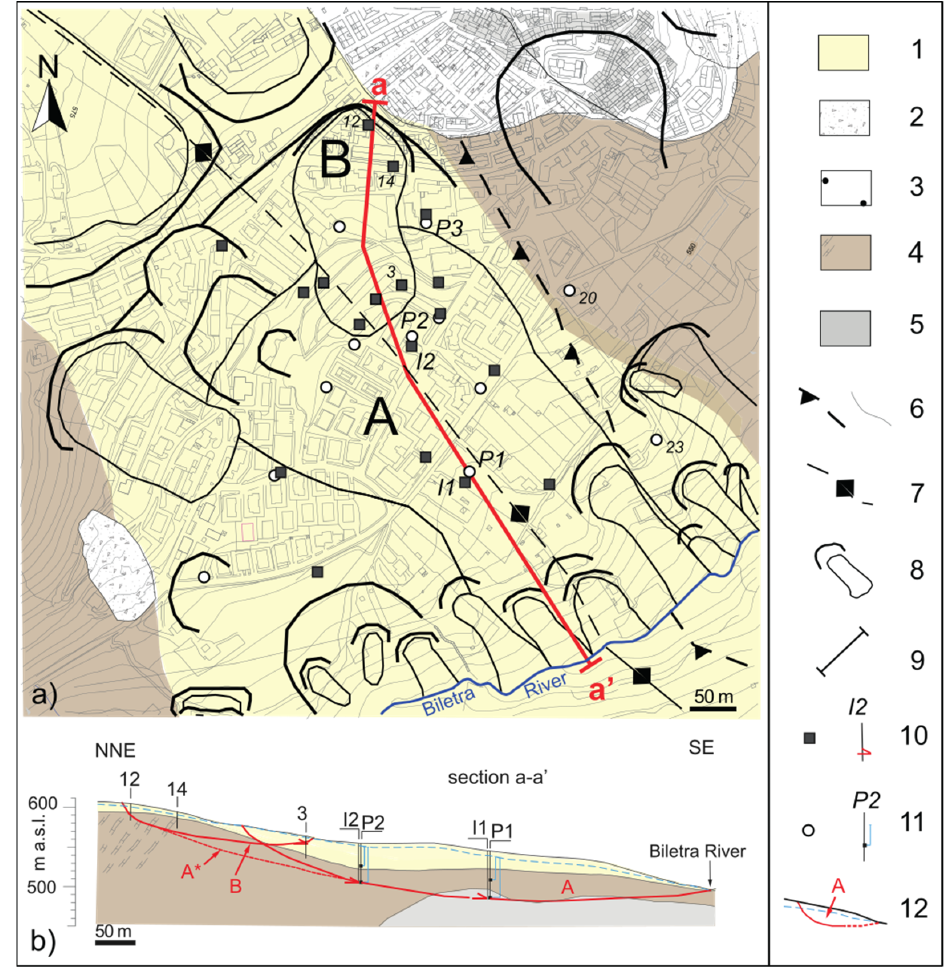
Figure 8. Bovino: ( a ) geological/geomorphological map with location of boreholes; ( b ) longitudinal cross section of Pianello landslide. Key: (1) altered Faeto Flysch cover; (2) debris; (3) Bovino Synthem; (4) Faeto Flysch (symbols indicate rocky disrupted strata); (5) Red Flysch; (6) thrust fault (left) and stratigraphic contact (right); (7) anticline axis; (8) landslide crown and body; (9) trace of cross section; (10) boreholes hosting inclinometer in map (left) and cross-section (right), arrow indicates the depth of shearing; (11) boreholes hosting piezometer in map (left) and cross-section (right), depth of cell and corresponding water head are also shown; (12) cross-section of landslide body and piezometric surface (failure surface dashed when inferred).